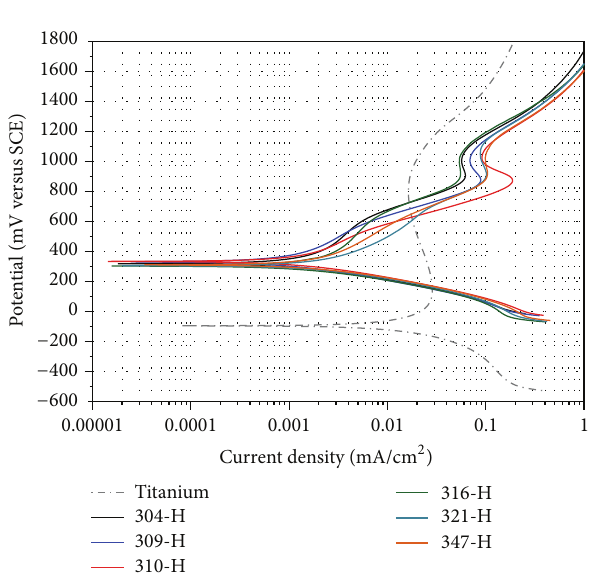
Figure 2: Polarization curves of materials in mouthwash at 37 ∘ C, dE/dt = 1.0